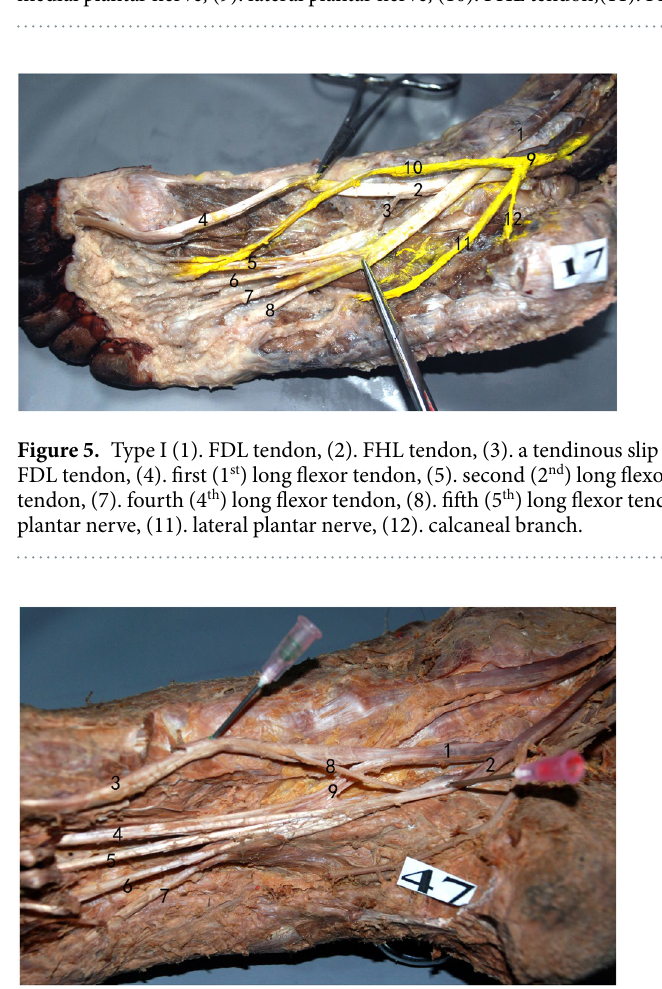
Figure 4. Relationship between the medial plantar artery and tendon (1). posterior tibial artery, (2). medial plantar artery, (3). lateral plantar artery, (4). superficial division of the medial plantar artery, (5). arterial arch at the superior border of the abductor hallucis, (6). deep division of the medial plantar artery, (7). tibial nerve, (8). medial plantar nerve, (9). lateral plantar nerve, (10). FHL tendon,(11). FDL tendon.